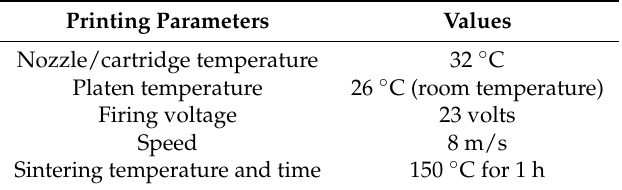
Table 2. Printing Table 2. Printing parameters.